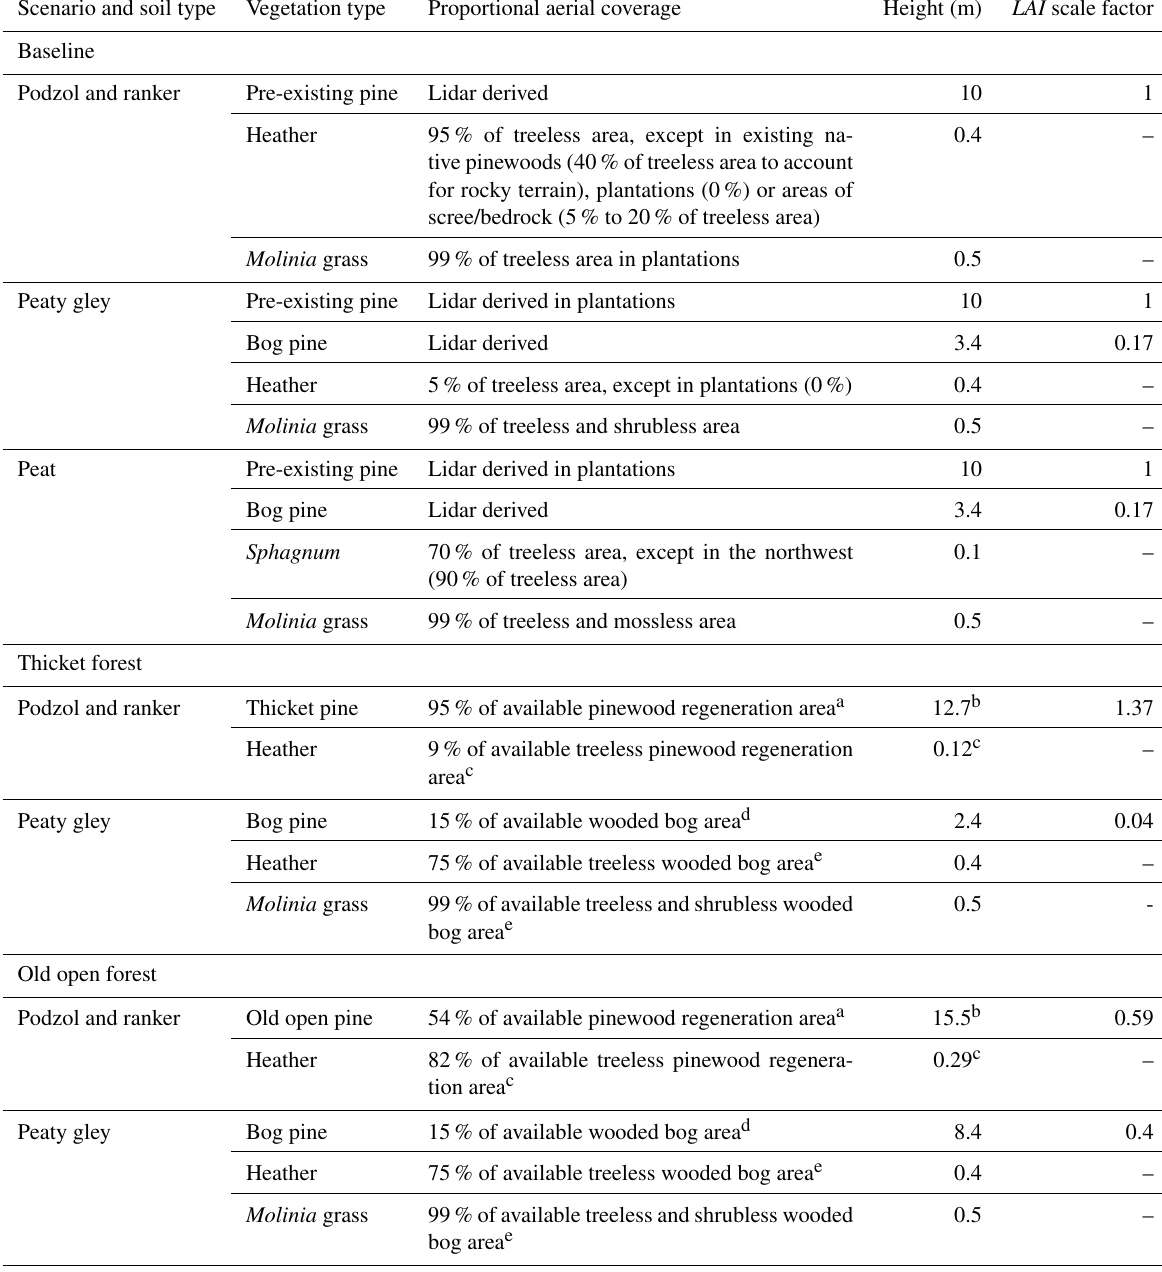
Table 1. Vegetation types in each scenario organised by soil type. All vegetation types are shown for the baseline scenario while only those in areas of pinewood regeneration on podzols/rankers or wooded bog on peaty gleys are given for the regeneration scenarios (see Fig. 1c). In areas where regeneration is not possible, vegetation characteristics remain as they were in the baseline scenario. The total coverage of all vegetation types plus bare earth sum to 100% within each cell of a given soil type. Leaf area index ( LAI ) scale factors convert calibrated values of LAI for pre-existing pine to LAI values for thicket, old open or bog pine.